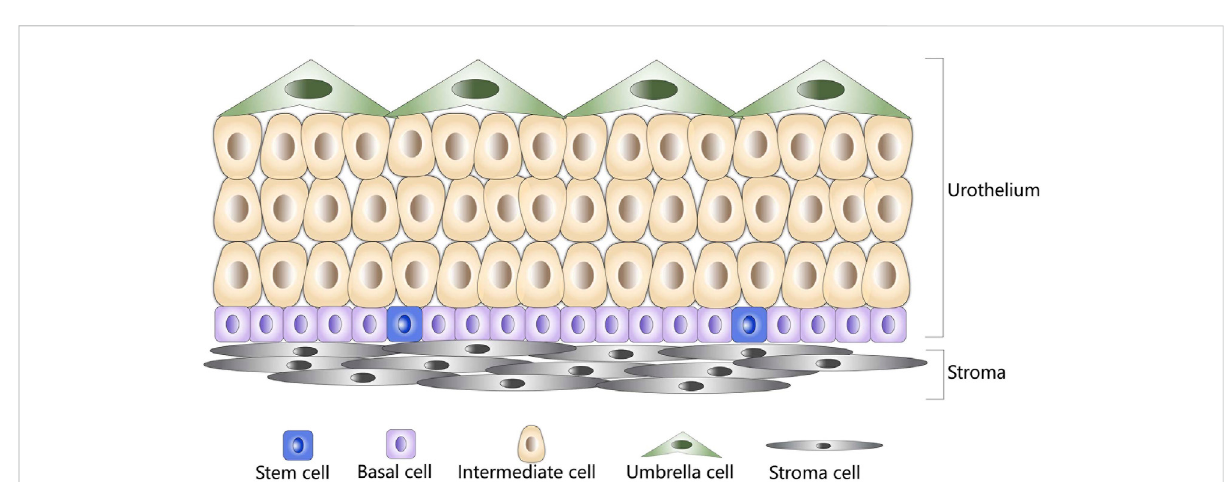
FIGURE 2 Schematicdiagram of normal bladder urothelium. Stem cells are shown in blue, basal cells are shown in purple, intermediate cells are shown in brown, umbrella cells are shown in green, and stroma cells are shown in